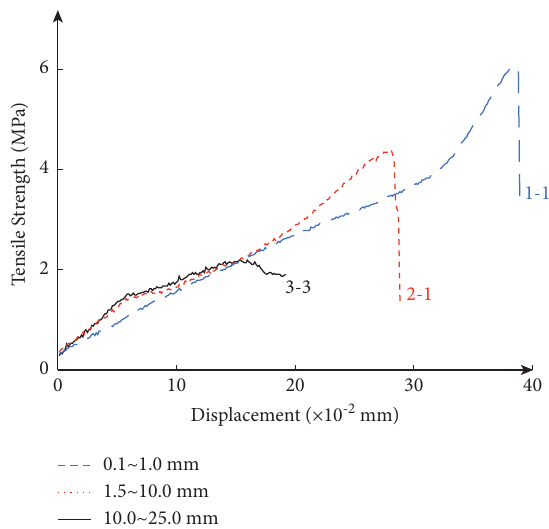
Figure 3: Central point tensile stress vs. displacement curve for specimens with different grain sizes.